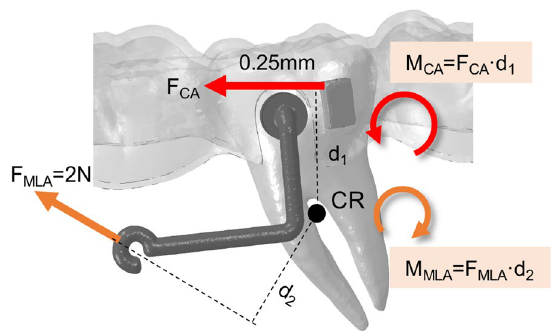
Fig. 11 Mechanical systems acting on M2. The red arrows indicate the force delivered by CA, and the orange arrows indicate the force delivered by